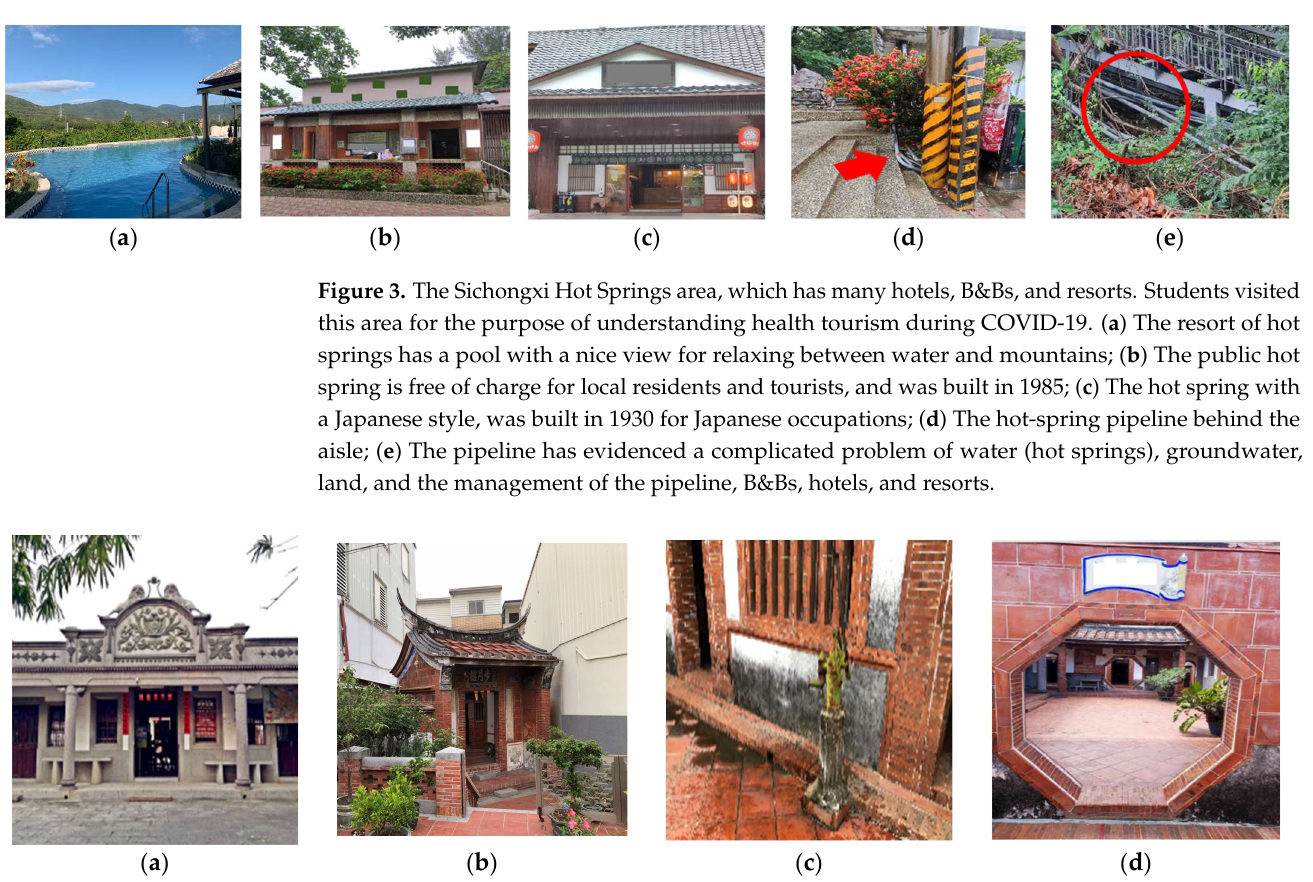
( e ) Figure 3. The Sichongxi Hot Springs area, which has many hotels, B&Bs, and resorts. Students vis- ited this area for the purpose of understanding health tourism during COVID-19. ( a ) The resort of hot springs has a pool with a nice view for relaxing between water and mountains; ( b ) The public